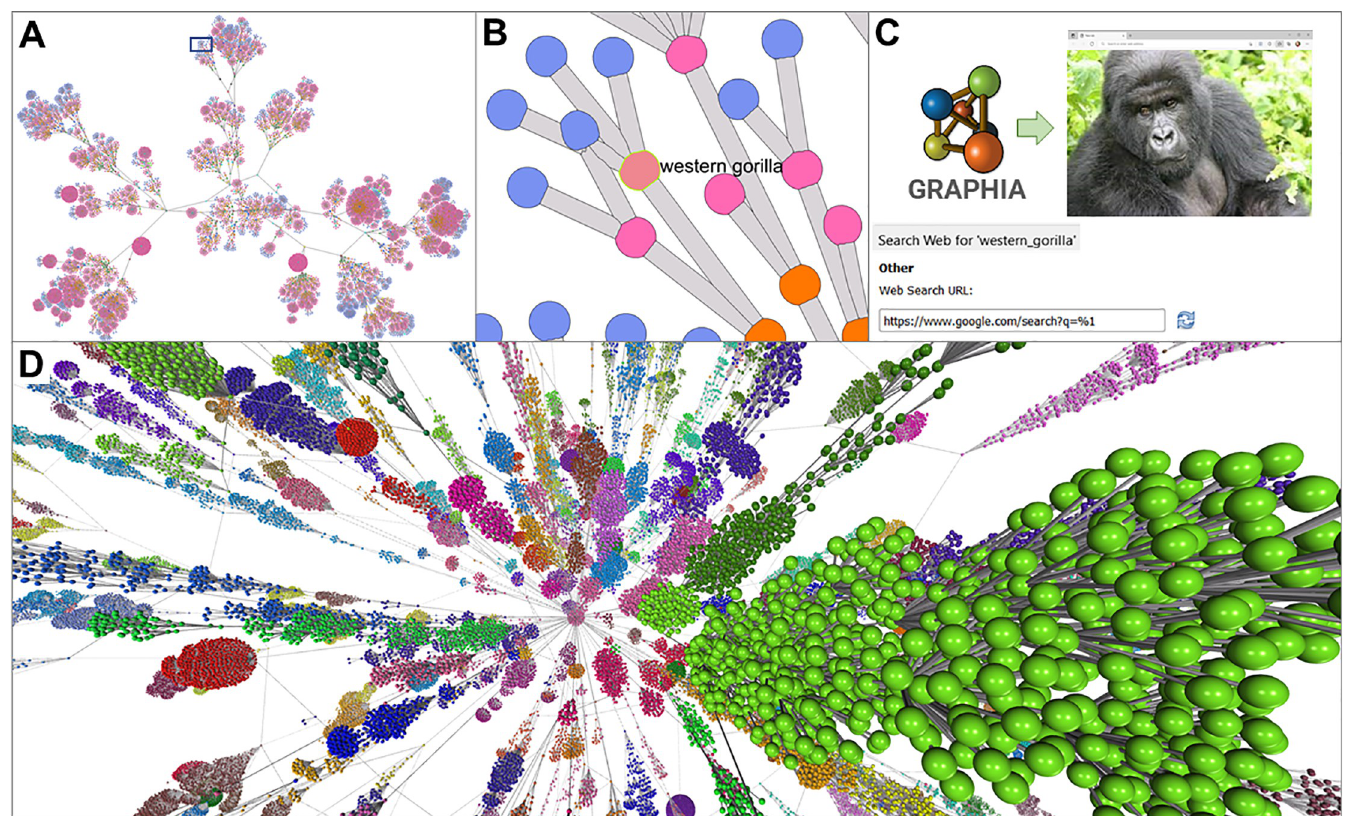
Fig 3. Visualisation of taxonomic trees. (A) A taxonomic tree of all mammals was downloaded from the NCBI’s Taxonomy database, with nodes coloured according to type, i.e. subspecies (blue), species (pink), genus (orange), etc. The graph comprised of 9,843 nodes and 9,862 edges and is shown with a 2D layout. (B) Zoomed-in view of the area in square shown in A, with a single node selected (Western gorilla). (C) Right click on a node provides the ability to search the web for the node identifier either via Google or through a predefined database selected in the Network tab of Options dialogue. (D) Taxonomic tree of all insects from the NCBI’s Taxonomy database, nodes coloured by Louvain cluster. The graph consists of 275,328 nodes and 275,528 edges and in this respect represents a large graph where visualisation in 2D is